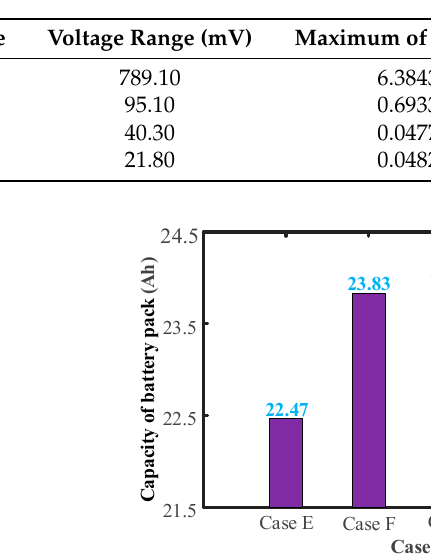
Table 4. Voltage range and SOC extremum after discharging.